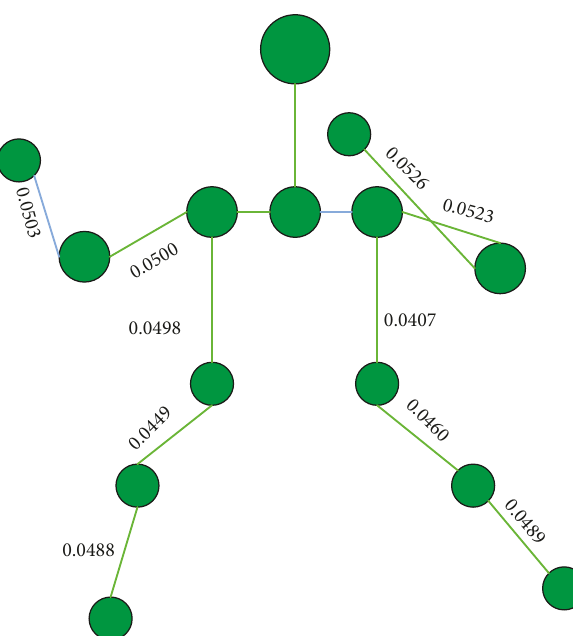
Figure 4: Schematic diagram of edge